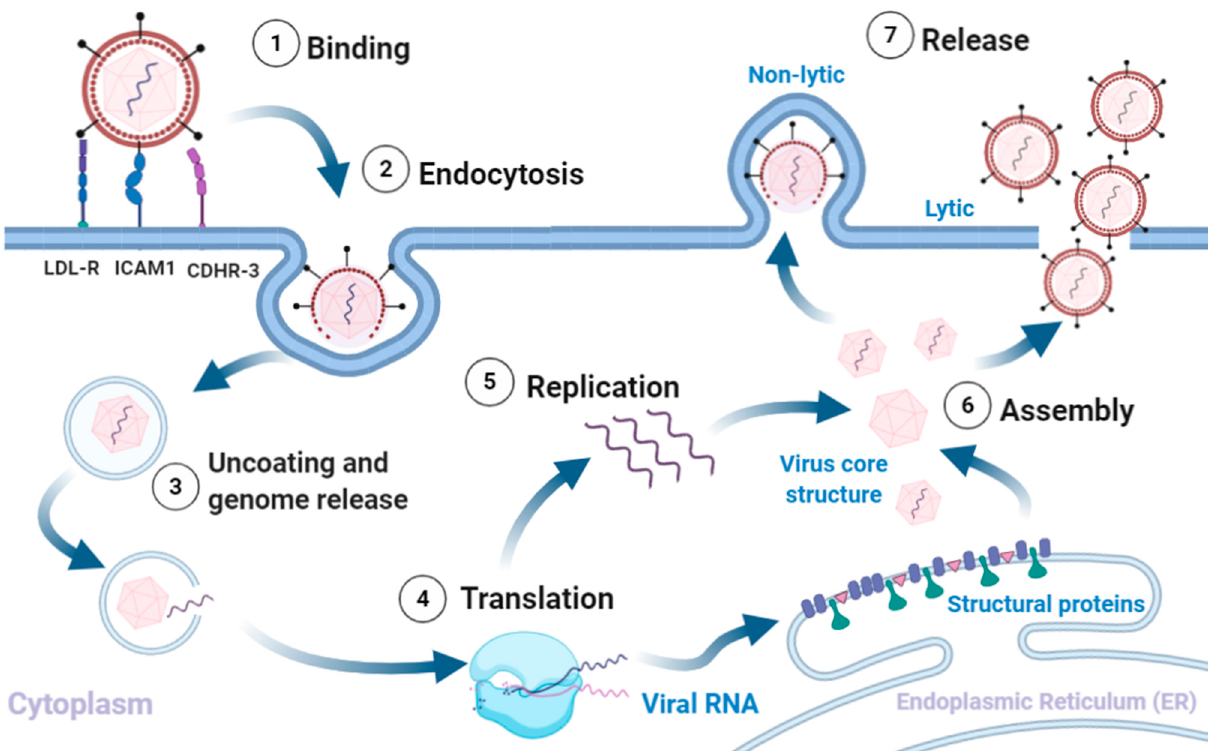
Figure 1. Rhinovirus lifecycle. (1) Binding of the virus to receptors on the plasma membrane initiates (2) endocytosis. The intake of the virion is followed by (3) uncoating of the capsid and release of the (+)ss-RNA into the host cytoplasm, which is (4) translated and processed into structural and non-structural proteins. The viral RNA dependent RNA polymerase converts the viral genome into (-)ss-RNA, that is (5) replicated into new (+)ss-RNA genomes. The new genomes become the template for translation into new viral proteins and replication into new genomes. The final stages involve (6) assembly of the structural proteins and RNA genome into capsids and (7) release of new infectious virions via lysis or non-lytic mechanisms. Adapted from [5,13,16,28]. Created with BioRender.com accessed on 12 December 2020.